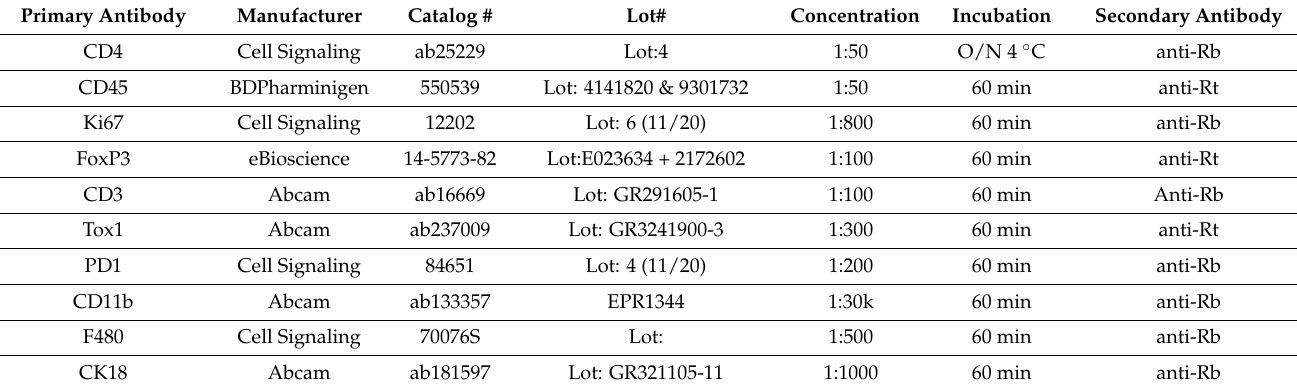
Table 1. Multiplex IHC Antibodies and